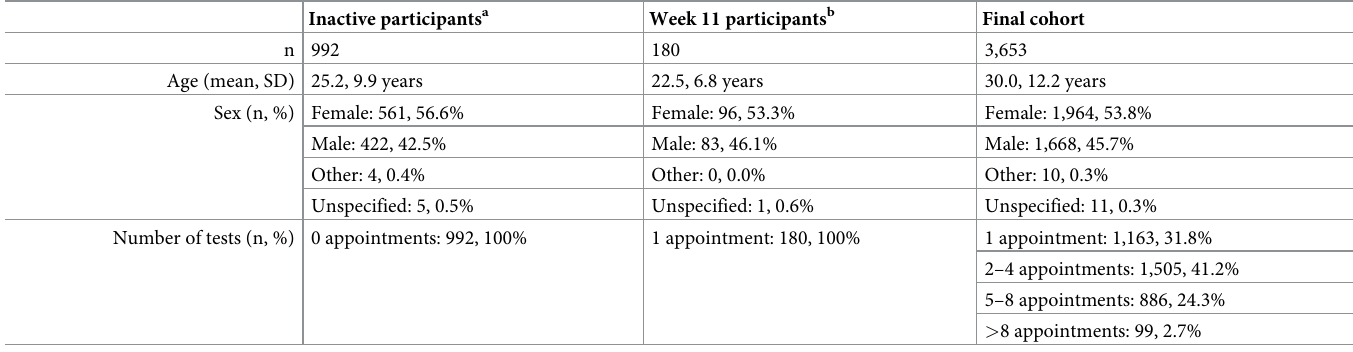
Table 1. Demographics of study